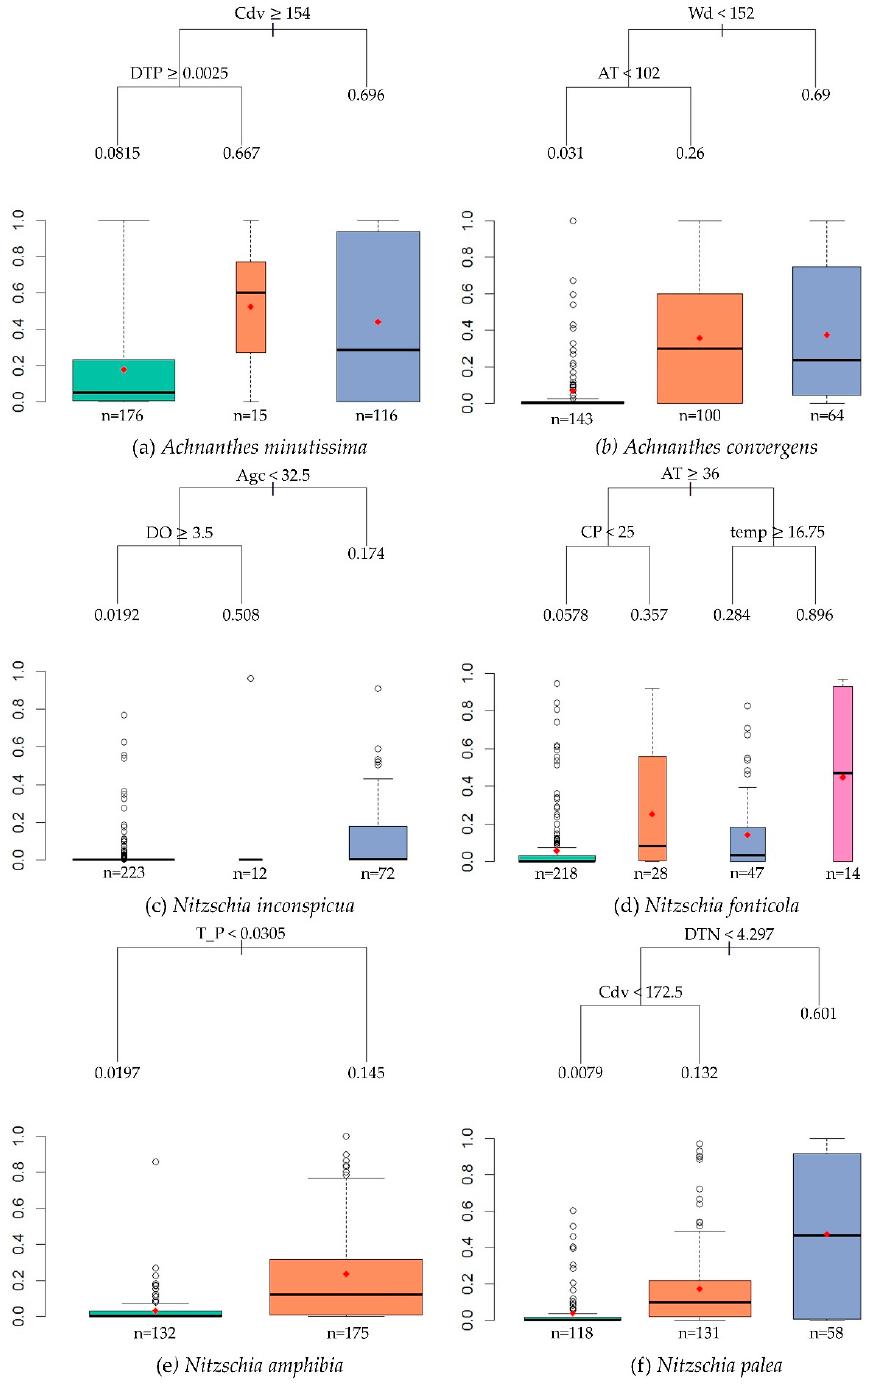
Figure 3. Regression tree results for six diatom species. ( a ) Achnanthes minutissima, ( b ) Achnanthes convergens, ( c ) Nitzschia inconspicua, ( d ) Nitzschia fonticola, ( e ) Nitzschia amphibia, ( f ) Nitzschia palea . As is shown in Figure 3f, the first split (307 sites) of N. palea was separated from the second (DTN < 4.297, 249 sites) and fifth (DTN ≥ 4.297, 58 sites) nodes, and the third (Cdv < 172.5, 118 sites) and fourth (Cdv ≥ 172.5, 131 sites) nodes were separated from the second node. N. palea had the lowest relative abundance (0.0079) with 118 sites in the third node and a relative abundance of 0.601 with 58 sites in the fifth node. Based on these results, the relative abundance of N. palea is expected to be high under the DTN ≥ 4.297